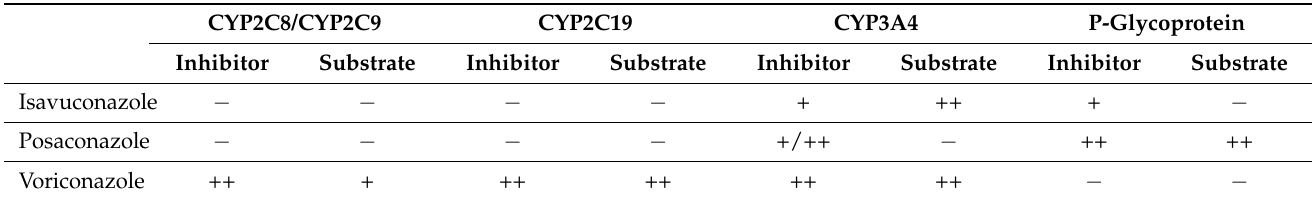
Table 1. Drug interaction potential and magnitude of effect in lung transplant recipients [9–13]. CYP2C8/CYP2C9 CYP2C19 CYP3A4 P-Glycoprotein Inhibitor Substrate Inhibitor Substrate Inhibitor Substrate Inhibitor